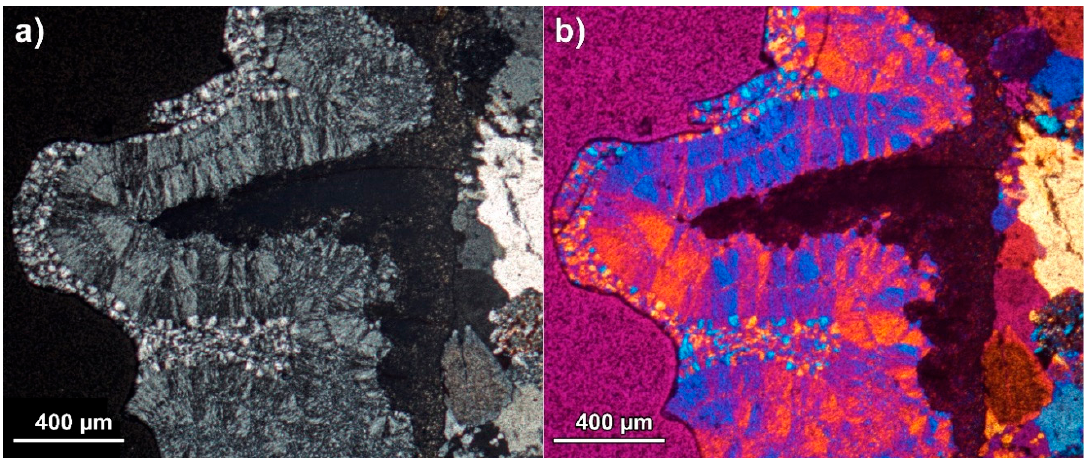
Figure 4. Petrographic images of postdiagenetical silicification in Montjuïc sandstone from the Castell unit corresponding to macroscopic sample C1 (in Figure 5). ( a ) XPL micrograph displaying complex joint filling (in this instance the sequence is amorphous opal, fibrous chalcedony, and chessboard chalcedony); ( b ) same image in XPL with compensator plate to highlight that chalcedony is basically of the length-fast type.